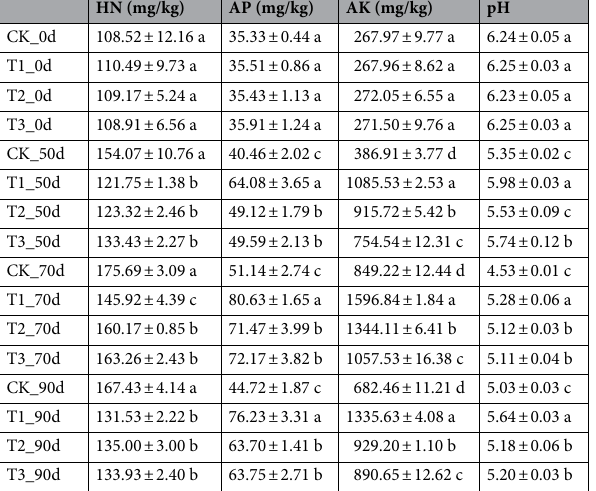
Table 2. Soil chemical properties in four treatments at 0 days, 50 days, 70 days and 90 days post-transplanted, respectively. Soil chemical properties in soils are presented as the mean ± SE. CK: the control group, T1: B. amyloliquefaciens ZM9 mix with marigold powder group, T2: B. amyloliquefaciens ZM9 group, T3: marigold powder. The different letters in the same column indicate significant differences as determined by LSD test. p <